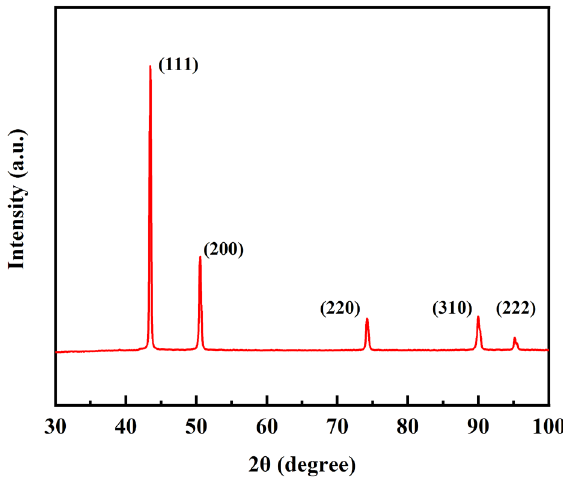
Figure 4. XRD patterns of a GNPs/Cu–Cr–Mg